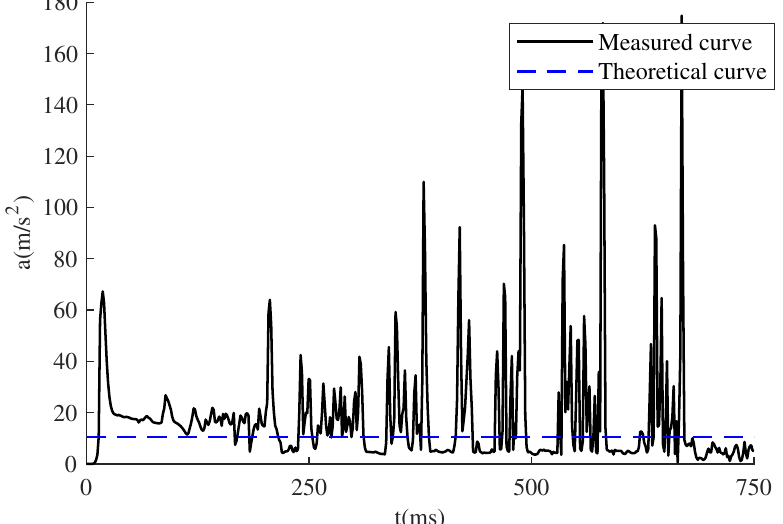
Figure 10. Acceleration–time curve of the slip